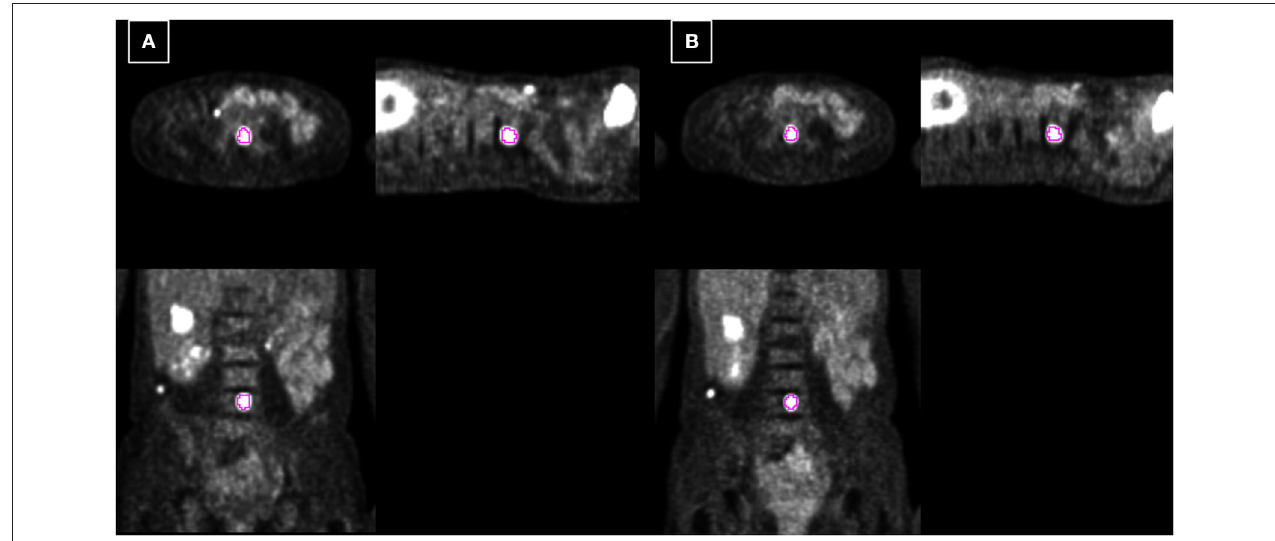
FIGURE 5 | Example 2: 54-year-old female with spine metastasis of melanoma. Each PET-CT (A) and PET-MR (B) was acquired 73 and 48min after injection. The tumor is delineated based on fixed 40% threshold to